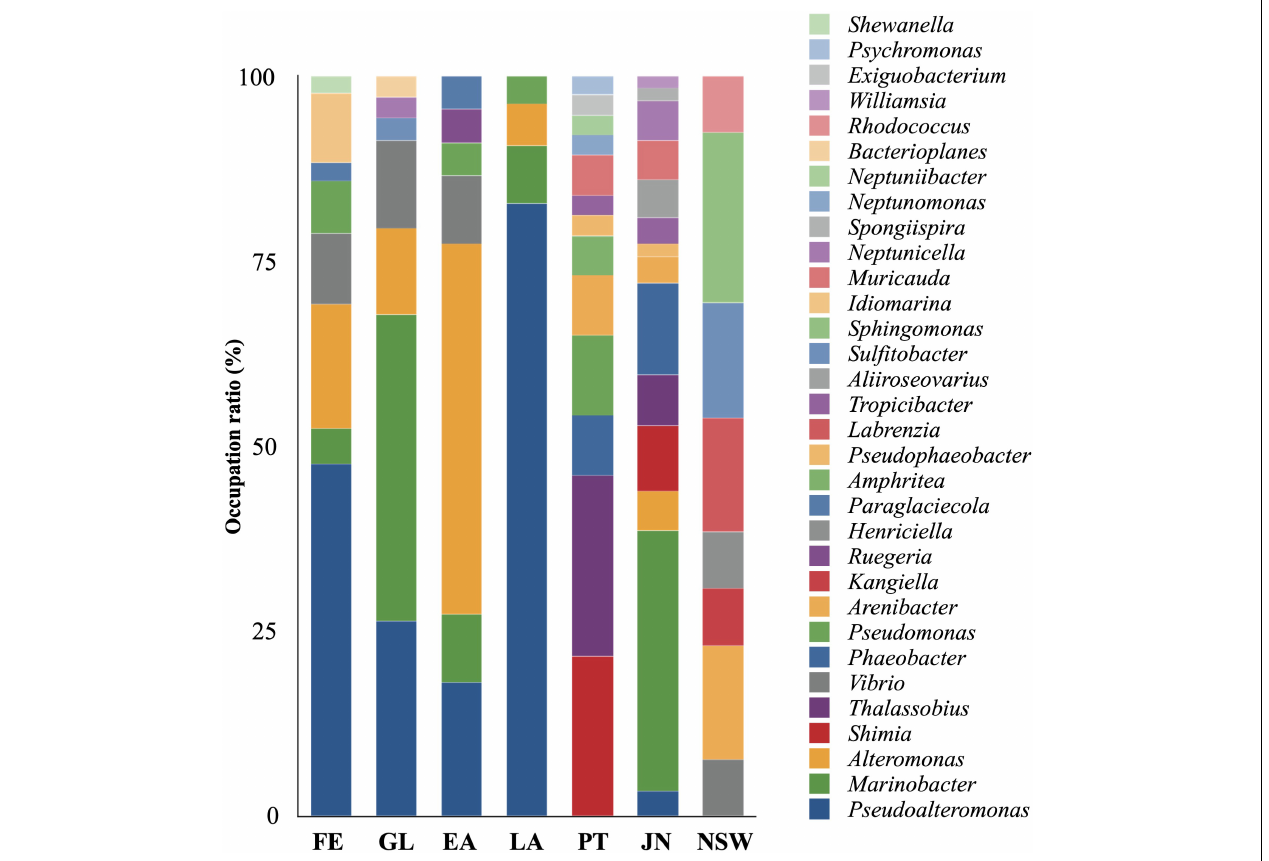
FIGURE 8 | Genus-level taxonomic distribution of isolates from sea cucumber and seawater. Bars represent proportion of isolates. FE, Fertilized egg; GL, Gastrula; EA, Early auricularia; LA, Late auricularia; PT, Pentactula; JN, Juvenile; NSW, Kumaishi nature